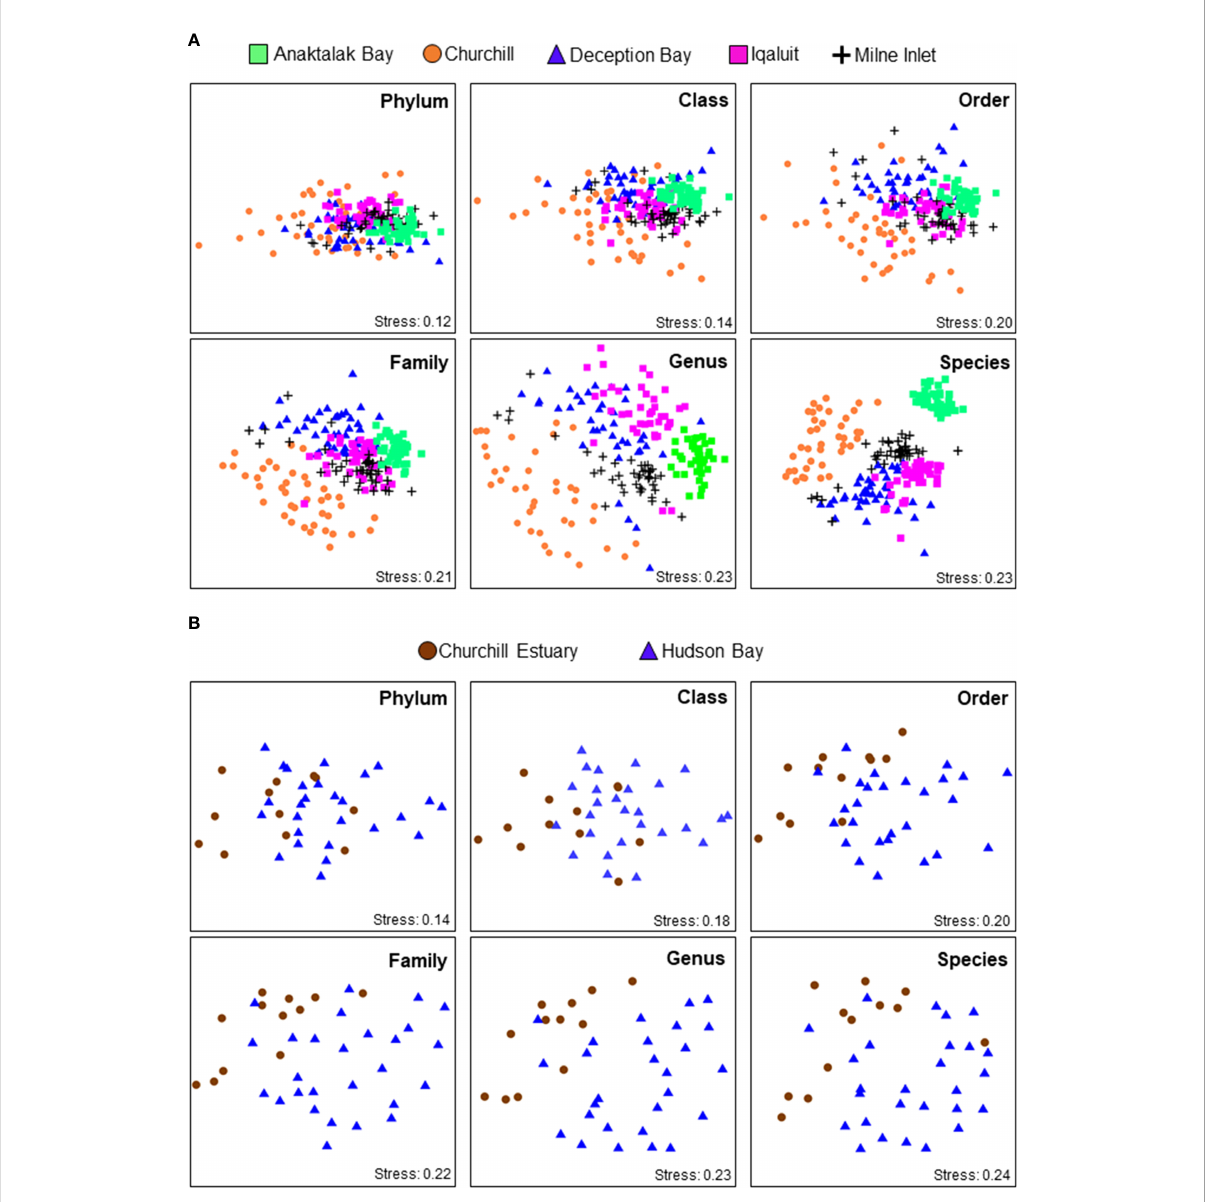
FIGURE 3 non-Metric multidimensional scaling (nMDS) ordinations of assemblage composition based on Bray-Curtis similarities matrix from square-root transformed abundance data among (A) Arctic ports and between (B) Churchill Estuary and Hudson Bay at various taxonomic levels. See Table 3 for full statistics and Figures 1 and 2C for geographic